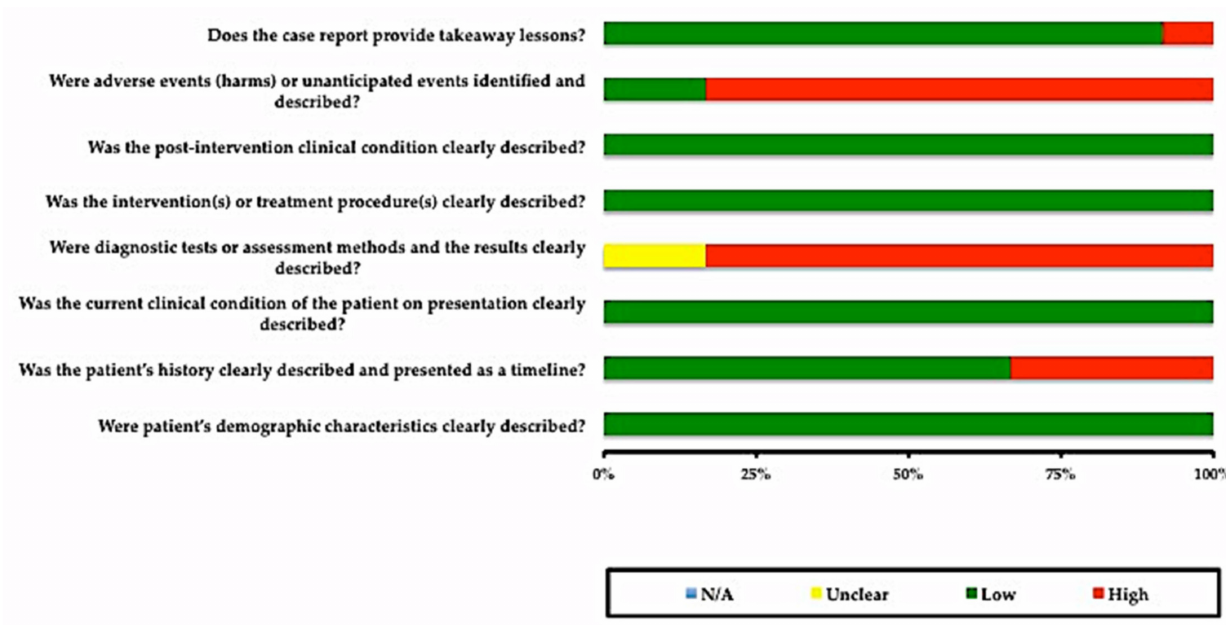
Figure 2. Risk of bias across the included studies for case reports.